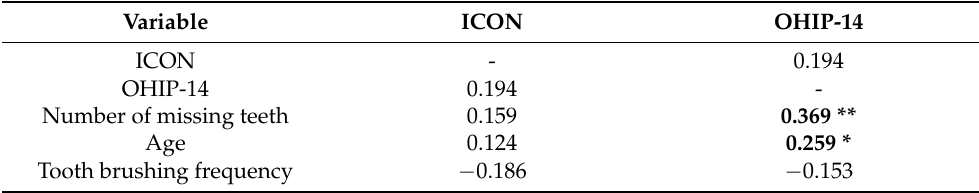
Table 3. Correlation between ICON and OHIP-14 total score, number of missing teeth, age and toothbrushing frequency ( n =